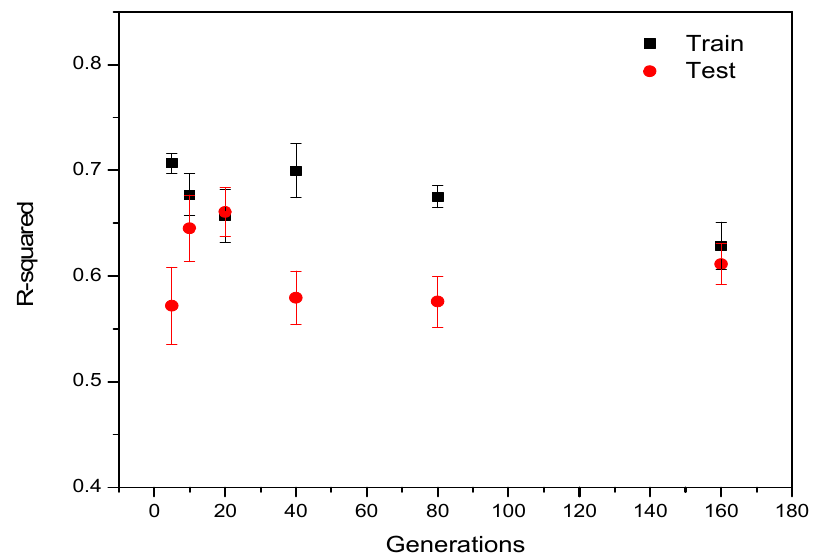
Figure 5. Effect of the number of generations on the variations in R 2 between the measurements and simulation.